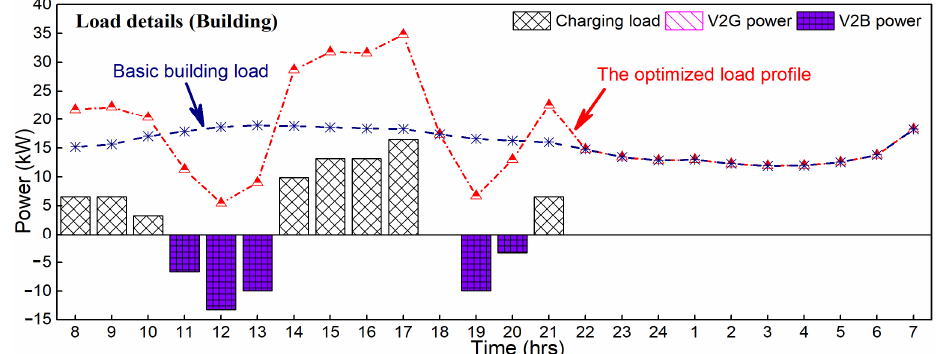
Figure 12. Outcome for EV charging of the building: basic building load refers to the building load without EV load profile; the optimized load profile refers to the basic building load plus the aggregated EV charging/discharging result based on the proposed model.